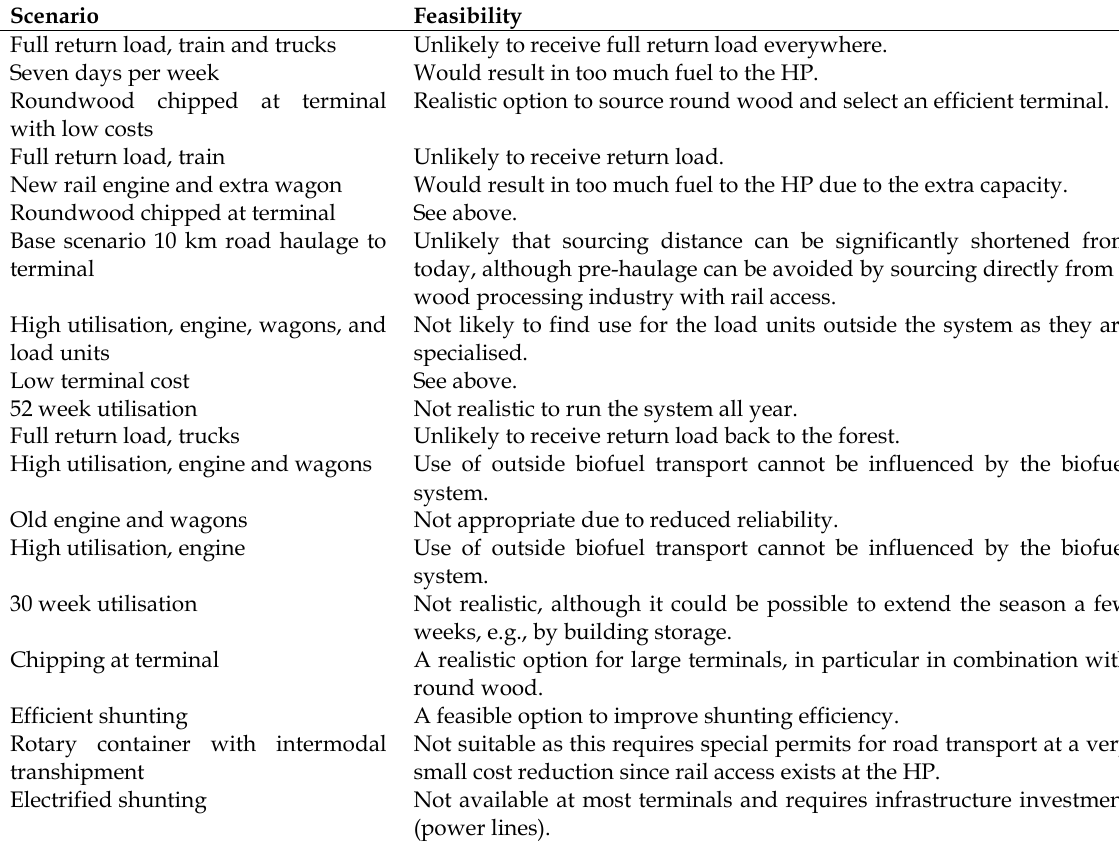
Table 4. Feasibility of